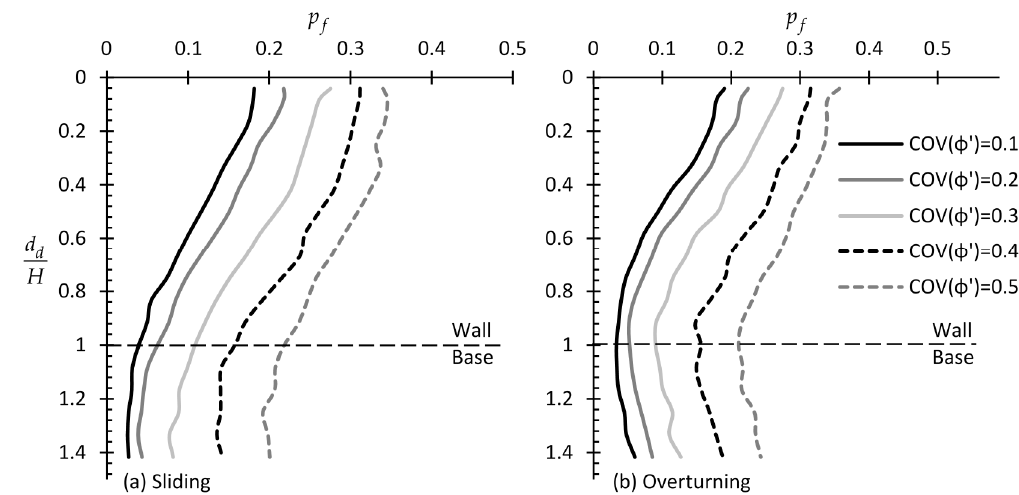
Figure 15. p f − d d / H curves for x / H = 0.5, θ / H = 2.08 and various values for COV of φ (cid:48) . Figure ( a ) refers Figure 15. f p - d d H curves for x H = 0.5, H θ = 2.08 and various values for COV of ' to the case of sliding wall, whilst figure ( b ) refers to the overturning ( a ) refers to the case of sliding wall, whilst figure ( b ) refers to the overturning wall.